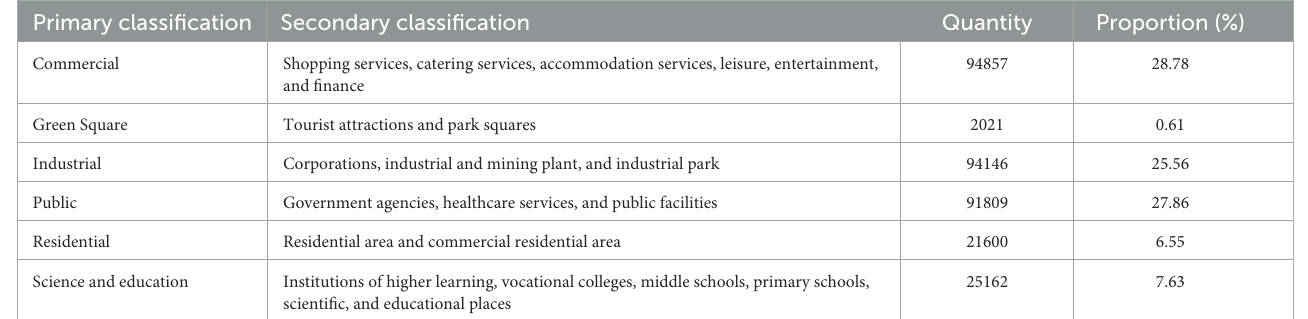
TABLE 2 POI data